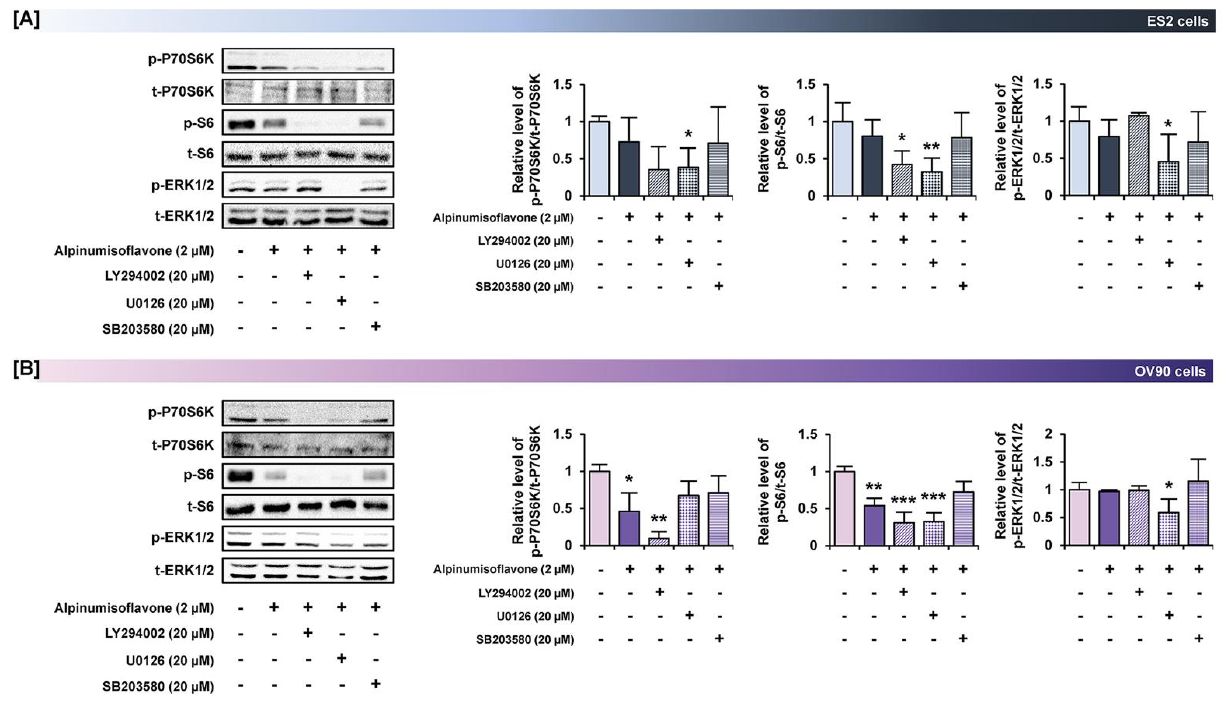
Figure 9. Effects of pretreatment of inhibitors for PI3K, ERK1/2 and P38 MAPK pathways prior to alpinumisoflavone treatment in ovarian cancer cells. ( A , B ) Western blot analysis revealed alterations in the phosphorylation of target proteins after pretreatment with each inhibitor for 1 h prior to alpinumisoflavone treatment. In ES2 and OV90 cells, a comparative graph represents the change in phosphorylation relative to the vehicle-treated control (100 %). All experiments were performed in triplicate. The significance between the vehicle and treatment groups is depicted by asterisks (* p < 0.05, ** p < 0.01 and *** p < 0.001).